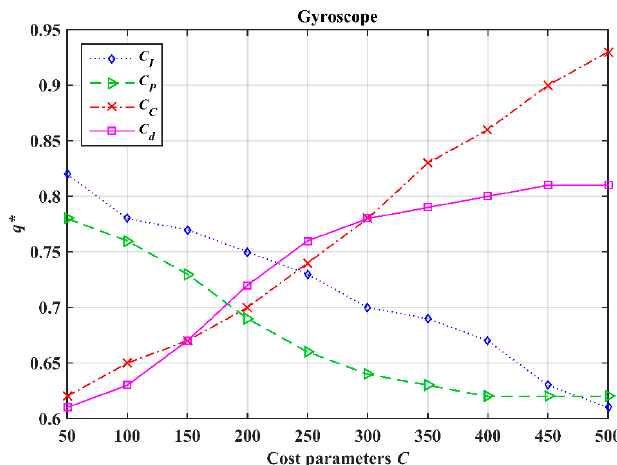
Figure 7. Total expected number of inspections versus the PM threshold 𝑤 (cid:2868) at 𝑞 = 0.90 .